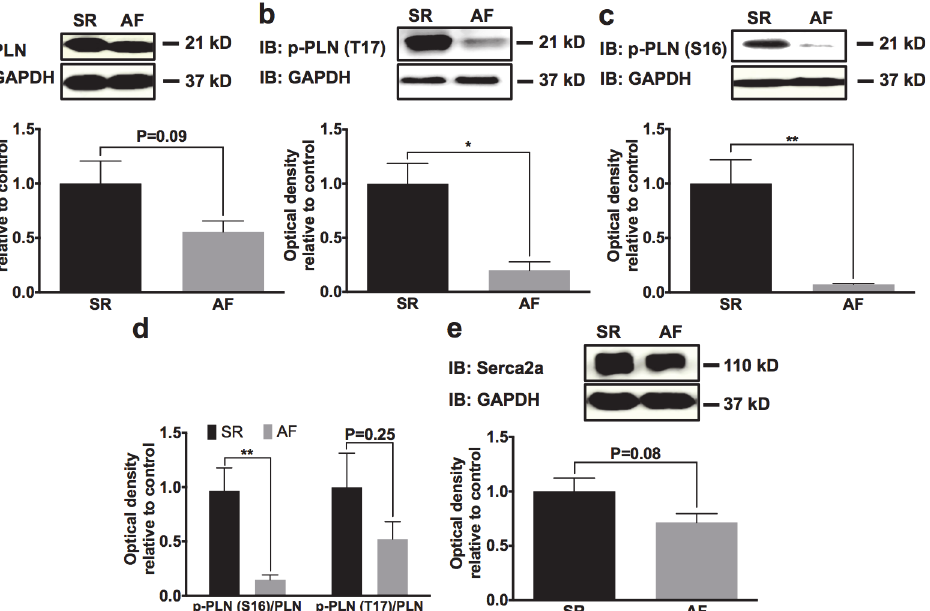
Fig 4. Alterations of sarcoplasmic reticulum Ca 2+ -ATPase (Serca) 2a and its regulator phospholamban (PLN) during AF. Total PLN ( a ) and PLN phosphorylated by CaMKII (Thr17; b ) or PKA (Ser16; c ) was downregulated in AF animals. d Phosphorylation levels relative to total PLN. e Serca2a protein analysis revealed a trend towards reduced protein expression associated with AF. Mean ± SEM optical density data normalized to GAPDH obtained from n = 5 Western blots per group are displayed. * P < 0.05; ** P < 0.01.